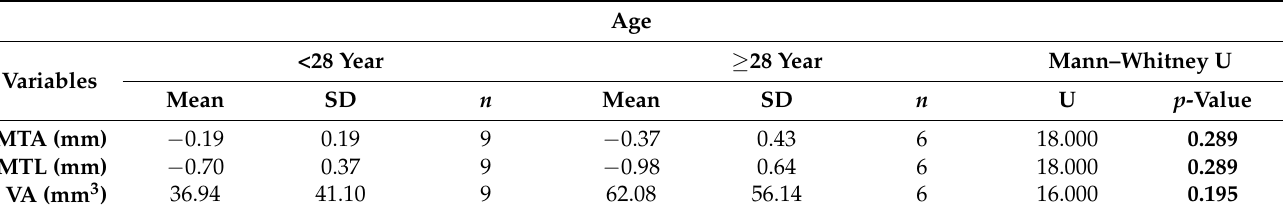
Figure 5. Case 7 ′ s 3D evaluation shows extensive loss marked by the deep dark blue color. Figure 5. Case 7’s 3D evaluation shows extensive loss marked by the deep dark blue color. Table 2. Age comparative analysis after three months.